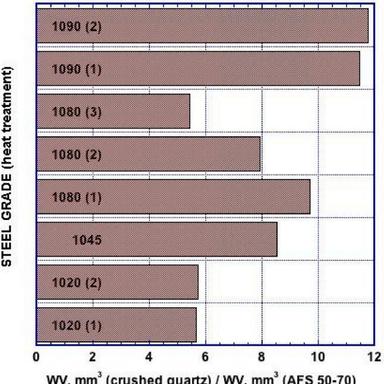
Effects of particle type on the relative wear volume (WV) produced by angular crushed quartz compared with rounded AFS 50–70 sand. Numbers in parentheses refer to different heat treatments given to the steels (Data are from Ref..).